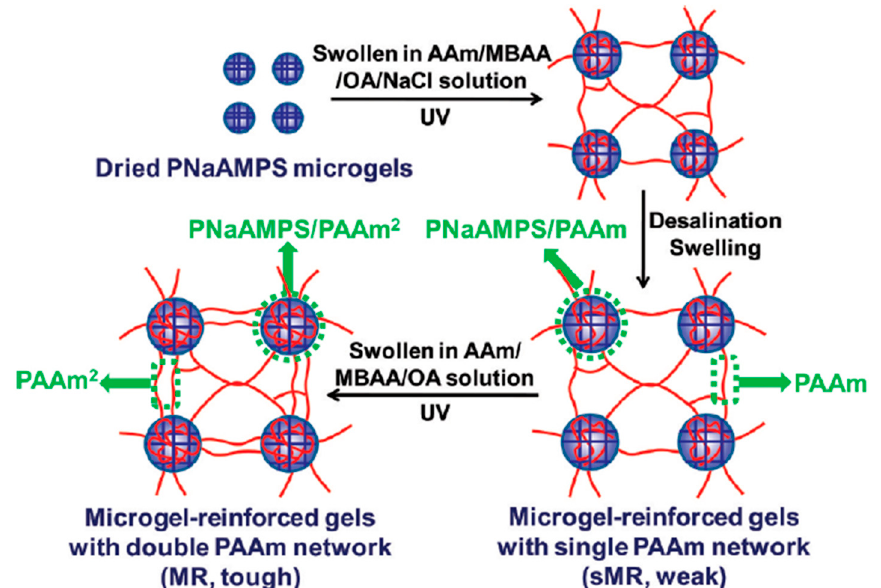
Figure 6. Preparation route followed for the synthesis of the PAMPS/PAAm/PAAm triple-network (TN) hydrogels. PAMPS: poly(2-acrylamido-2-methylpropane sulfonic acid); PAAm: polyacrylamide. Adapted and reprinted with permission from [20]. Copyright 2012 American Chemical Society.